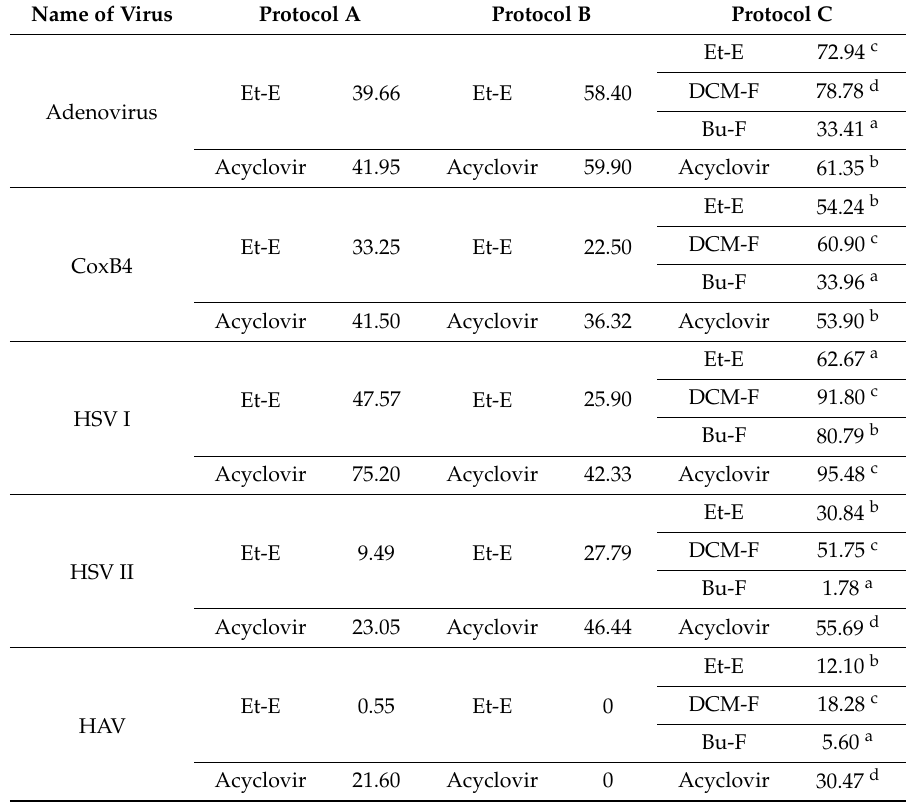
Table 1. Antiviral activity of Hibiscus schizopetalus.